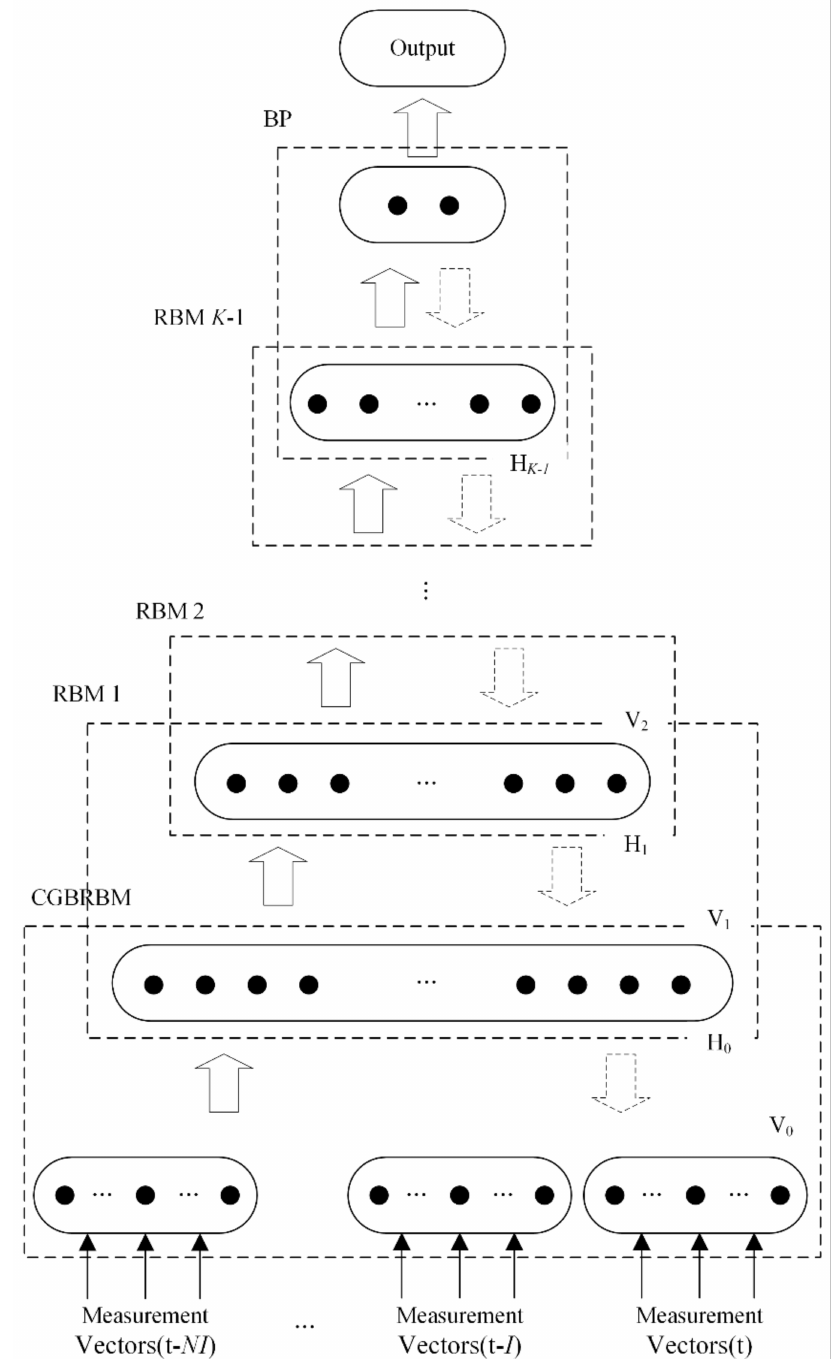
Figure 3. The structure of the